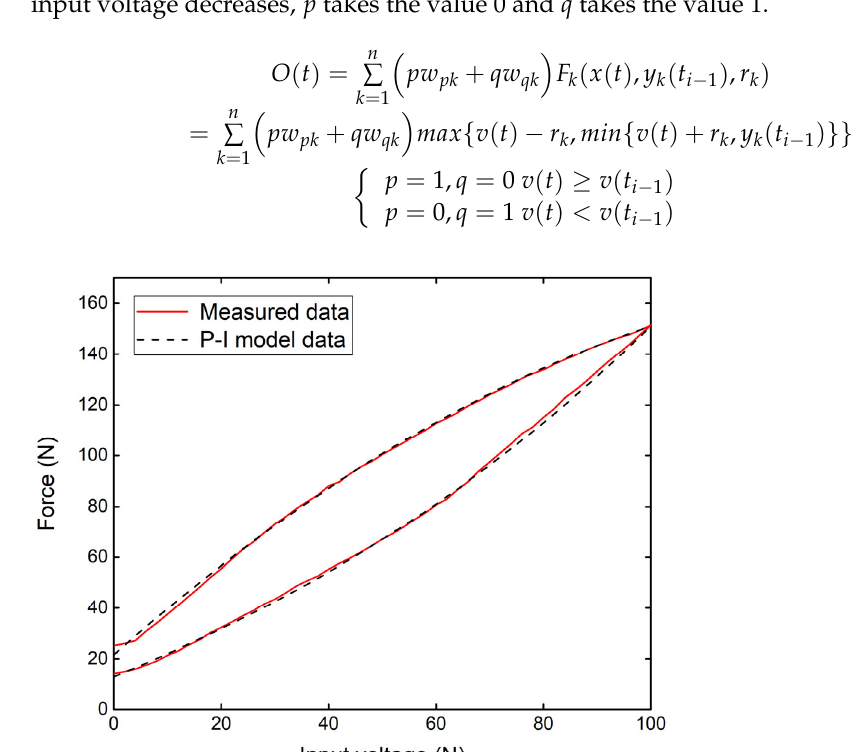
Figure 5. Comparison of the simulated hysteresis loop using the P-I model and the measured loop.